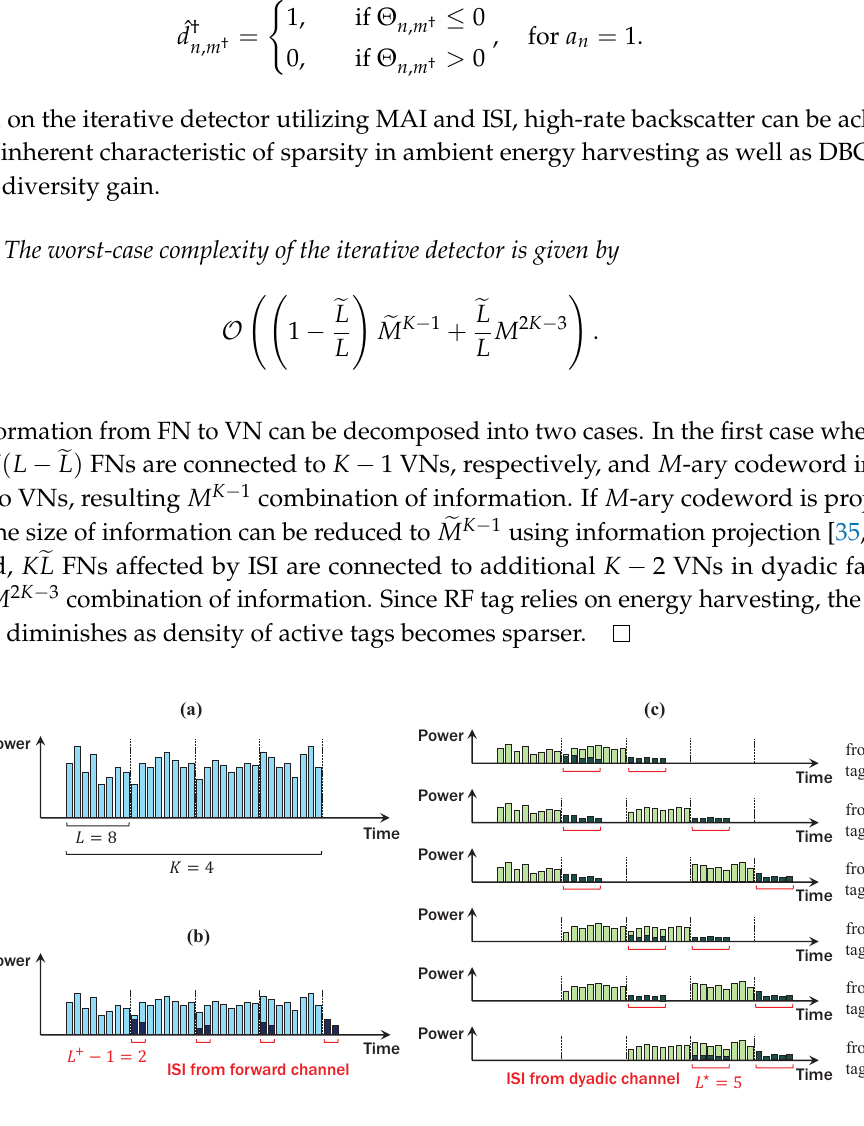
Figure 7. Example of AmBC signals in DBC ( K = 4, L = 8, L + = 3). ( a ) transmitted signal from AP; ( b ) received signal at tag with ISI from forward channel; ( c ) superposition signal at AP with ISI from a dyadic